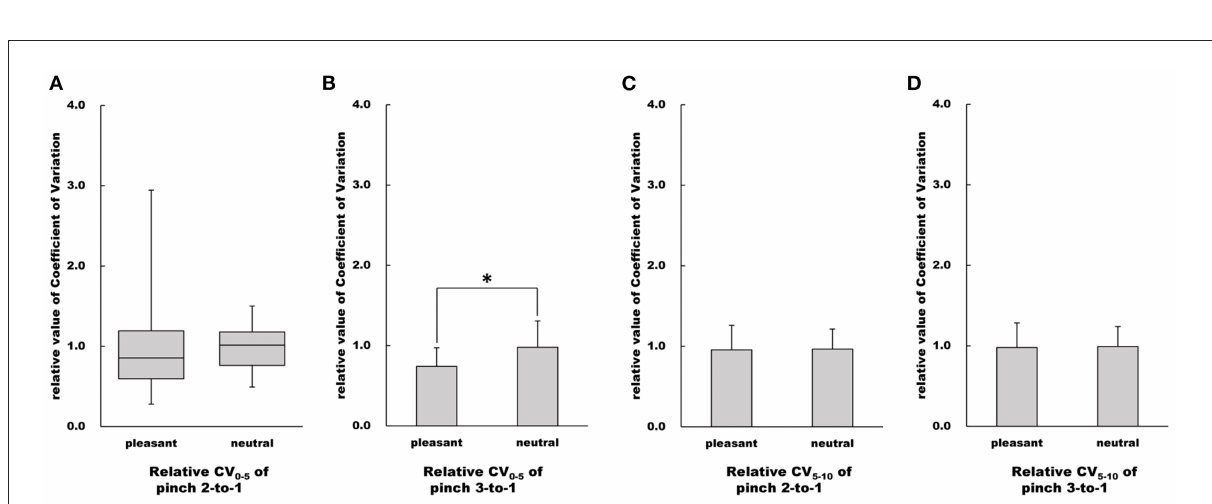
FIGURE8 Influence of emotion on relative value of CV. (A–D) Show relative CV values in the pleasant and neutral image conditions, respectfully. For parametric data, relative CV values are represented as mean and standard deviation. For non-parametric data, relative CV values are represented using the box and whisker plot, with the median shown as the middle horizontal line, the upper and lower quartiles indicated as boxes, and the maximum and minimum indicated as whiskers. The vertical axis shows relative CV value, and horizontal axis shows the specific image condition (pleasant and neutral). * p <